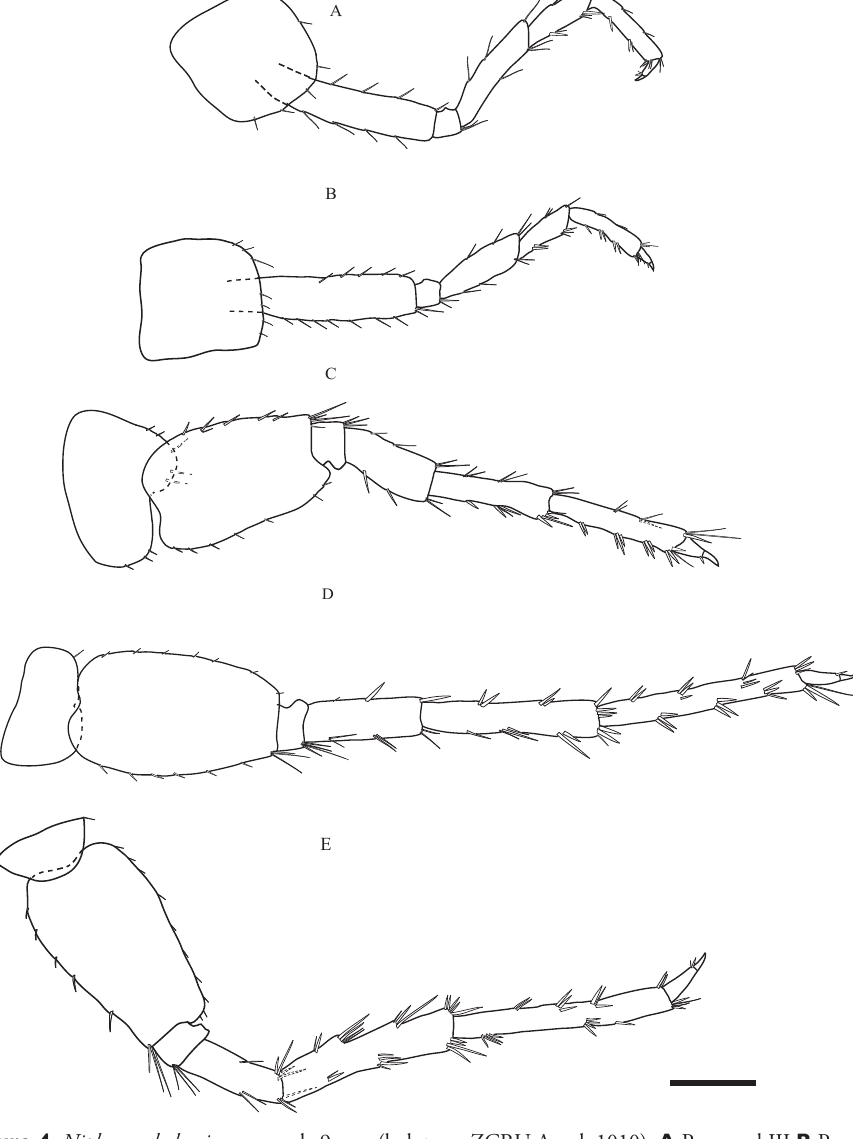
Figure 4. Niphargus hakani sp. n., male 9 mm (holotype, ZCRU Amph.1010). A Pereopod III B Pereo- pod IV C Pereopod V D Pereopod VI E Pereopod VII. Scale bars: 1mm ( A–E